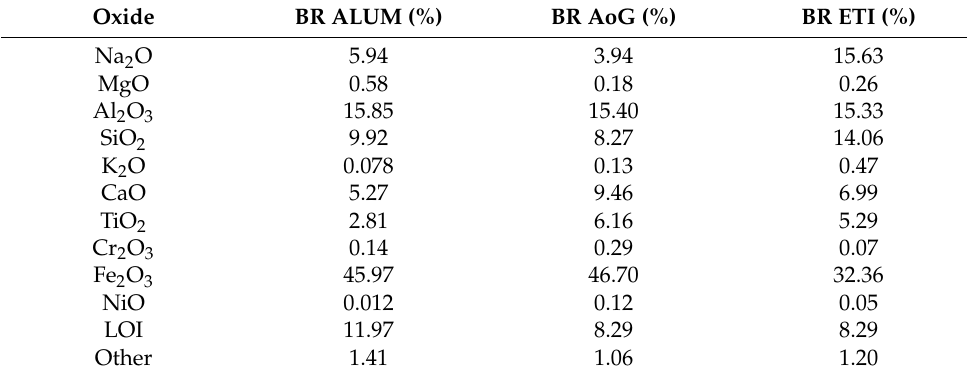
Table 1. Chemical composition of bauxite residue samples (XRF).